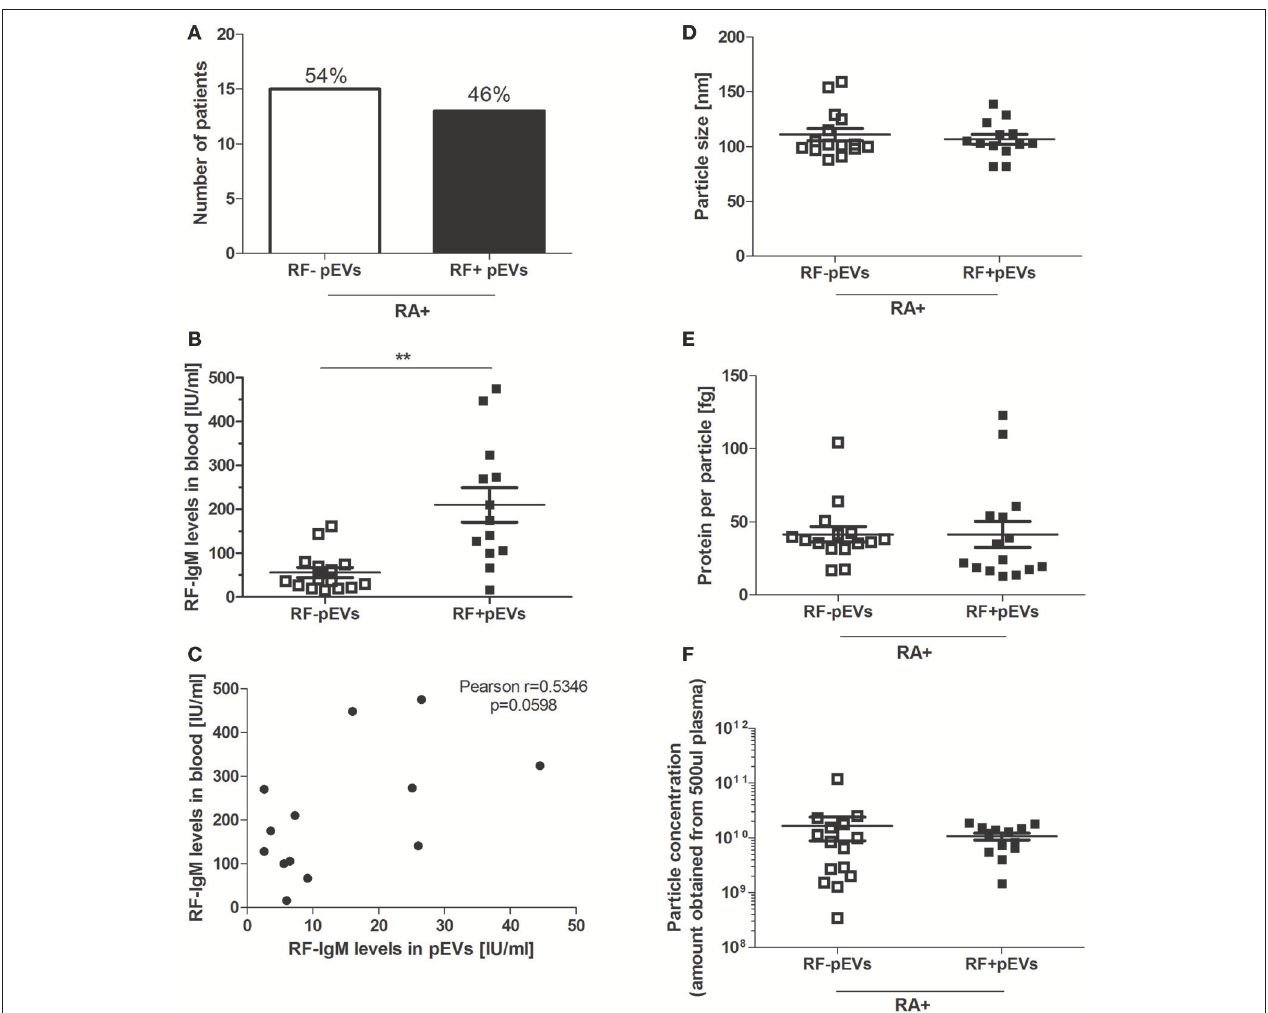
FIGURE 4 | IgM-RF detection in fraction 5 of SEC separated platelet free plasma. IgM-RF levels on pEVs isolated from all 28 RF + RA patients were measured by ELISA and percentage of RF + RA patients with or without IgM-RF + pEVs are shown (A) . From these 2 subdivided groups IgM-RF blood levels are shown individually per patient (B) . Correlation of IgM-RF levels on pEVs and levels in platelet free plasma (pfp) of RF + RA patients with IgM-RF + pEVs is shown (C) . Pearson correlation coefficient (r) and their p -value is shown. Mode particle size (D) , protein content per particle (E) and amount of particles (F) from pEVs of these subdivided groups (RF + RA patients with IgM-RF + pEVs or IgM-RF − pEVs) are shown, measured by NTA and micro-BCA protein assay. Statistically significant differences were determined by Mann–Whitney test, ** p <